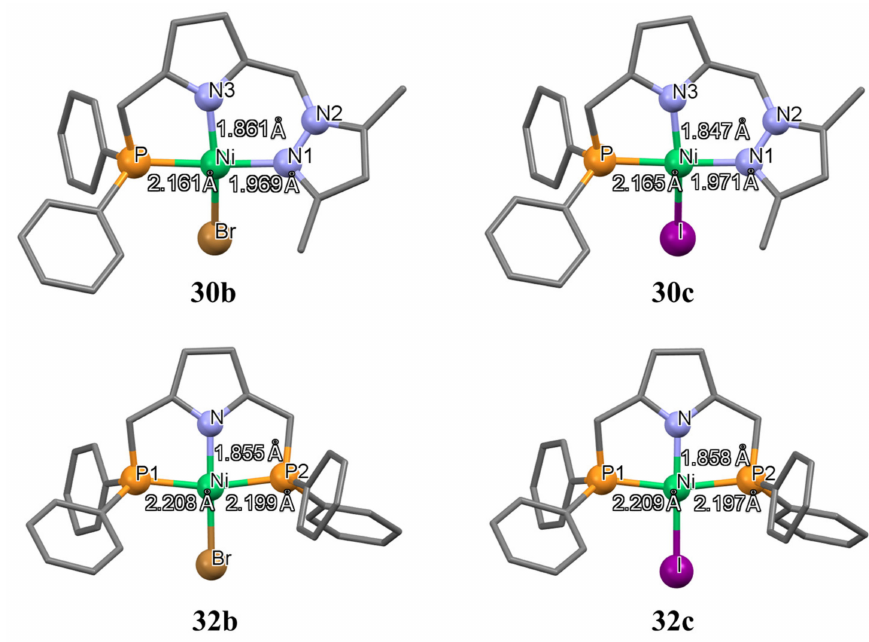
Figure 7. Structures of complexes 30b , 30c [117], 32b and 32c [121]. The authors carried out a systematic study of the polymerization of norbornene using symmetric ( 32a – 32c ) and unsymmetrical ( 30a – 30c ) pyrrole-based complexes. Nickel pincer NNP complexes in the presence of MMAO or EtAlCl 2 showed high yields and high activities (in the range of 10 7 g of PNB mol − 1 h − 1 ). Meanwhile, symmetric PNP complexes, on the contrary, turned out to be ineffective catalysts in this process, suggesting that with an increase in the number of N donors, the yield and activity of the catalytic system increase, following the order PNN > PNP (Table